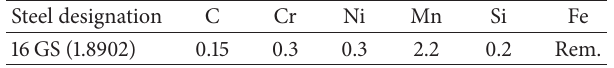
Table 3: The welding process